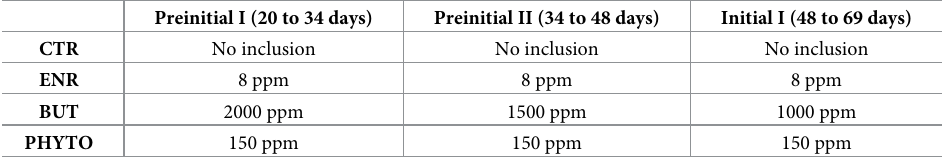
Table 2. Treatments, doses, and